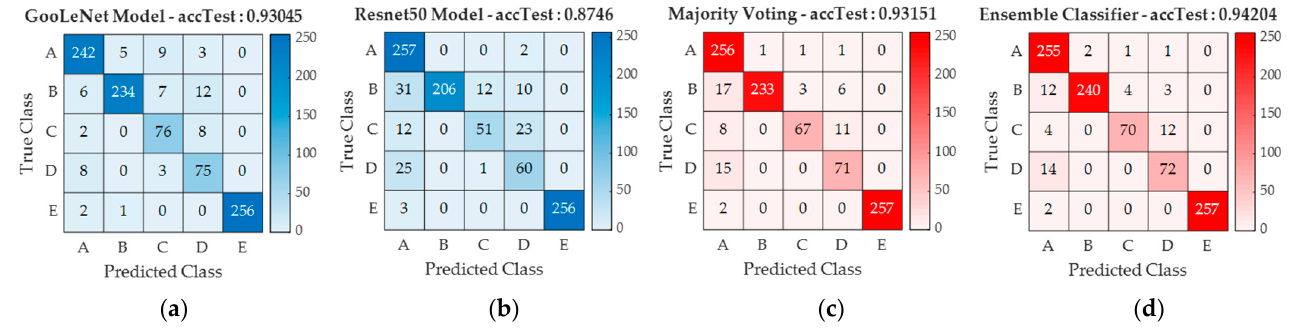
Figure 10. Confusion matrix: ( a ) best, ( b ) weakest, ( c ) voting, and ( d ) ensemble, of CLAHE dataset.